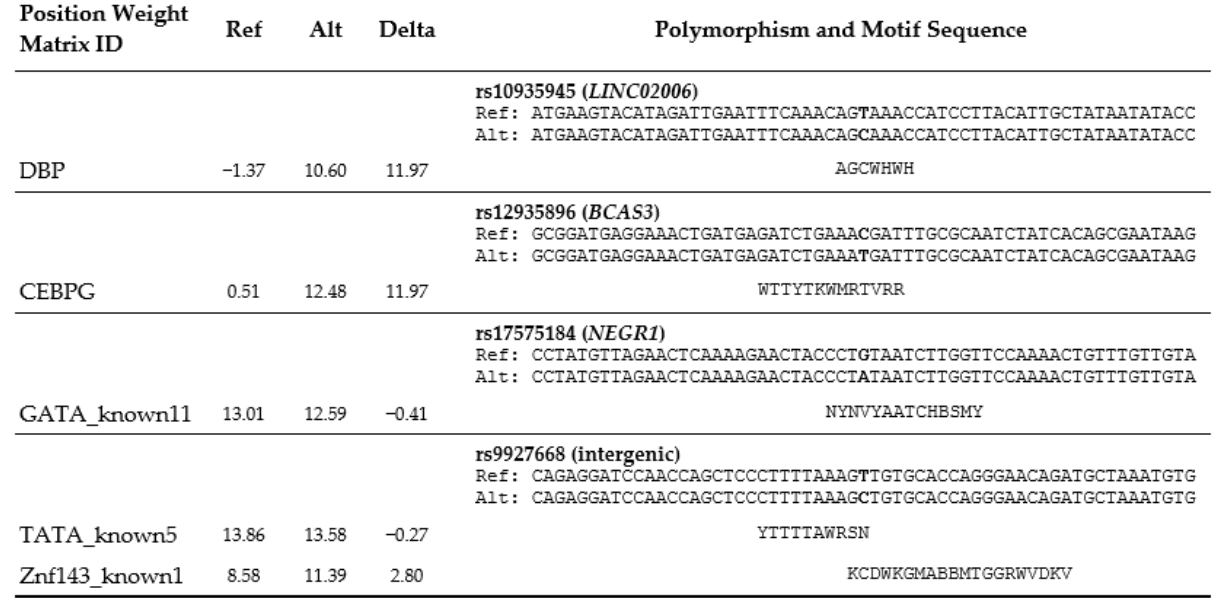
Figure 1. Possibly altered regulatory motifs. Based on HaploReg database (https://pubs.broadinstitute.org/mammals/haploreg/haploreg.php) [22]. Position weight matrix motifs in biological sequences [34]. Allele variants are indicated in bold. Ref, reference sequence; Alt, alternative sequence.